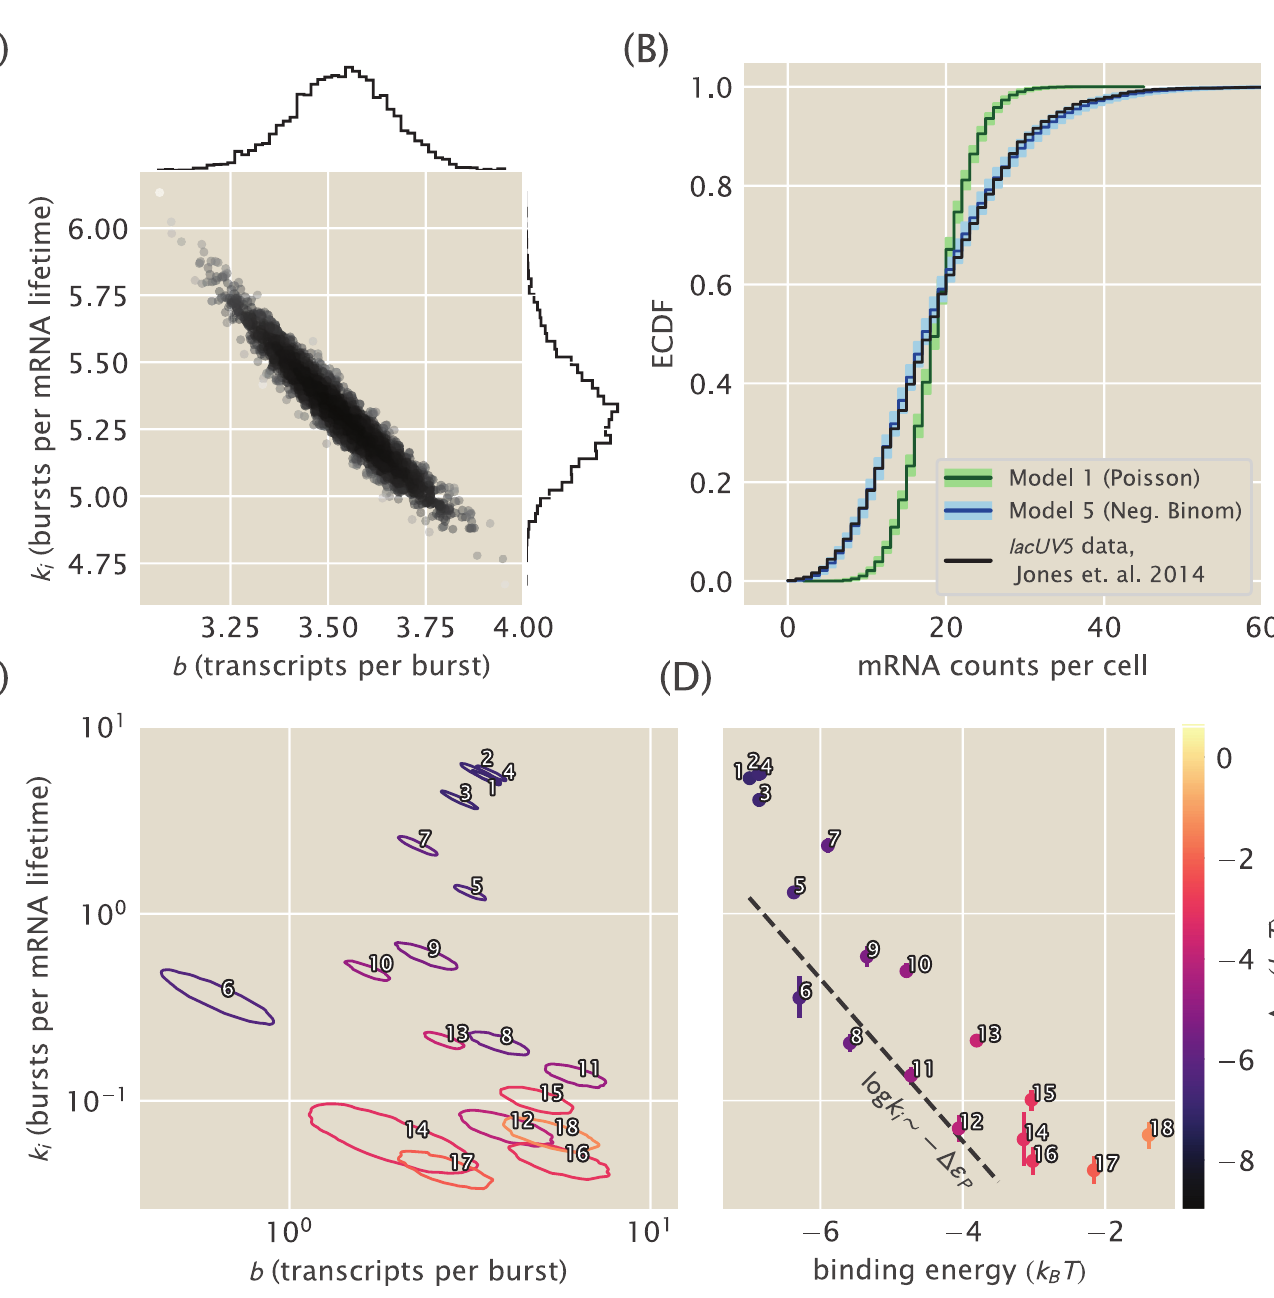
PLOS Computational Biology | https://doi.org/10.1371/journal.pcbi.1008572 January19,